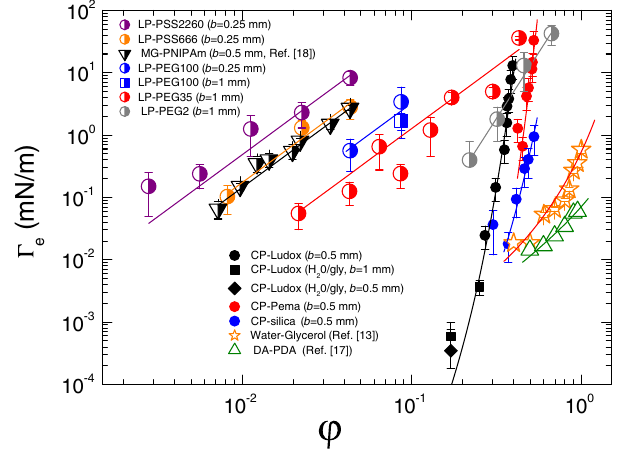
FIG. 1. Nonequilibrium interfacial tension Γ for aqueous e solutions of polymers (semifilled symbols), colloidal suspensions (full symbols), and water-glycerol and DA-PDA mixtures (empty symbols, Refs. [13] and [17], respectively). The labels indicate the gap b for the Hele-Shaw experiments; the solvent is water unless specified otherwise. For all LP systems except the shortest polymer, LP-PEG2, the lines are power-law fits with an exponent 2. For all the other samples, the lines are fits of Eq.